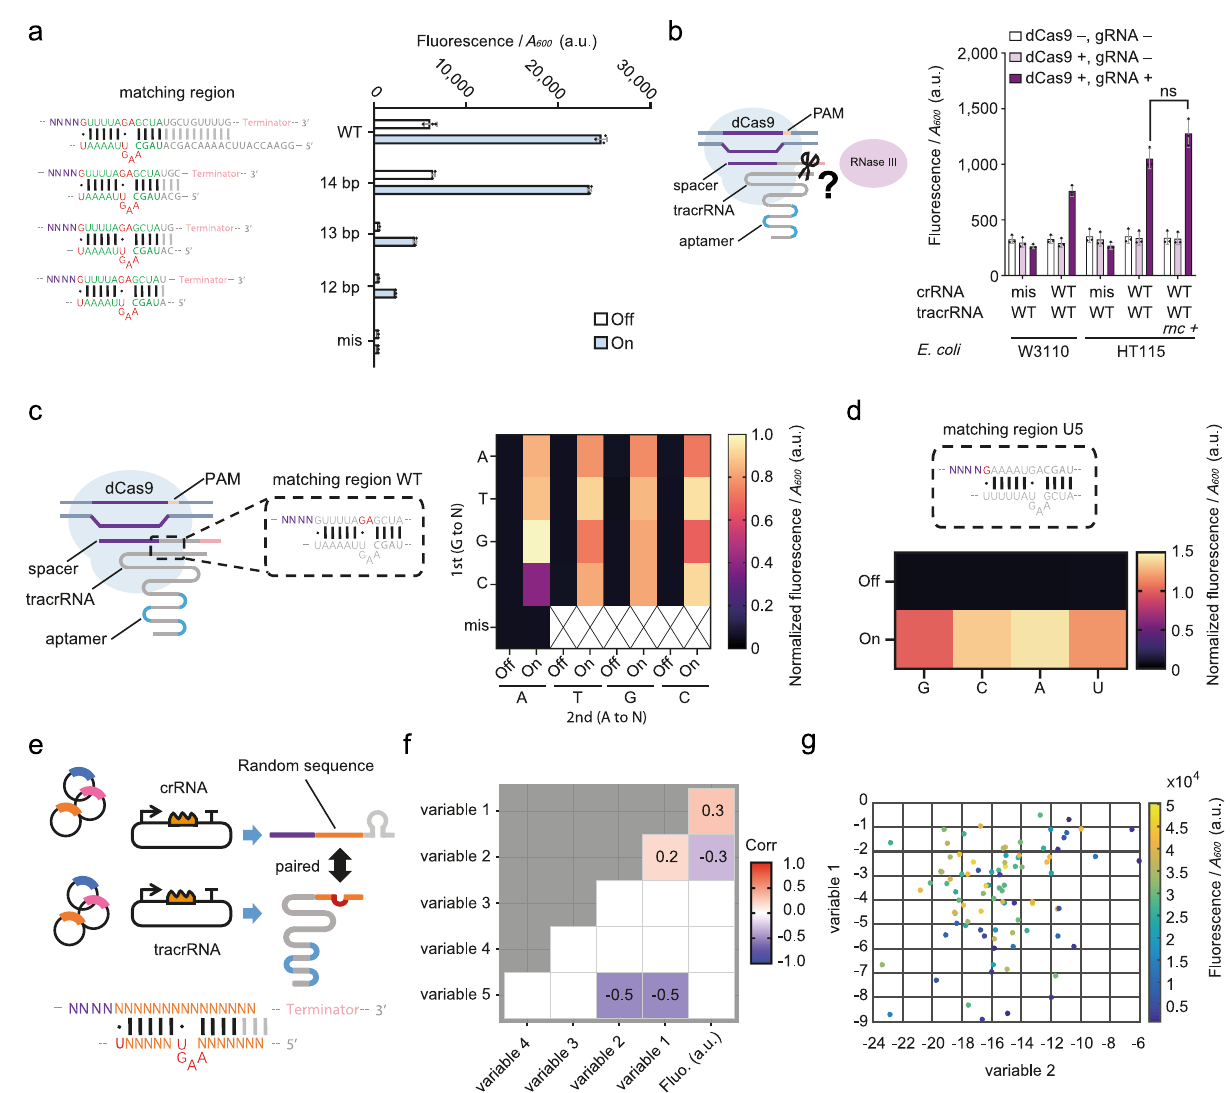
Fig. 2 Mode of action of reprogrammed crRNA-tracrRNA pairs. a The length of the hybridized region affects the CRISPR function. The diagram on the left depicts the sequences used and the bar chart on the right exhibits the CRISPRa output. The label ‘ mis ’ indicates the WT crRNA has a mismatched spacer (LEB3) with the target UAS (LEA2). Error bars, mean values + / − s.d. ( n = 3). b RNase III is unnecessary for dual-RNA mediated CRISPRa. The label ‘ mis ’ is the same as in a . Statistical difference was determined by a two-tailed t test: p = 0.0615, t = 2.577. Error bars, mean values + / − s.d. ( n = 3). c Saturated mutations of the GA site. The diagram on the left shows location of the GA site. The heat map on the right shows the results. All the genes were induced for ‘ On ’ state, no induction for the ‘ Off ’ state. Data normalized by the output level from the ‘ GA ’ at ‘ On ’ state. ( n = 4). d Saturated mutations of the base guanine in the core hybridized region. The U5 crRNA-tracrRNA pair was used as an original crRNA version, which had been shown as a functional crRNA-tracrRNA pair (see in Fig. 1e). The data was normalized by the output level from the sample with the WT U5 ‘ G ’ at ‘ On ’ state. ( n = 4). e Schematic showing the randomized sequence library of crRNA-tracrRNA pairing. The orange bases show the paired randomized sequences, and purple ‘ N ’ s stand for the spacer region, a fi xed sequence (LEA2) among all variants. The red bases in tracrRNA are not changed. f Pearson correlation coef fi cient between individual features (variables, see METHODS) and the output fl uorescence level. Blank indicates no signi fi cant correlation ( p >0.05). Numbers represent correlation coef fi cients (Corr). g Reprogrammed tracrRNA-crRNA library represented by variable 2 for crRNA-tracrRNA heterodimer binding and variable 1 for crRNA folding. Each dot represents a sample from the library. Samples are colored according to their average fl uorescence level ( n = 3); a.u., arbitrary units. p value summary: **** p value<0.0001, 0.0001<*** p value<0.001, 0.001<** p value<0.01, 0.01<* p value<0.05, p value ≥ 0.05: ns. Source data are provided as a Source Data fi RNase III gene ( rnc ) knockout strain HT115. Our results showed that RNase III is not required for our CRISPRa system.